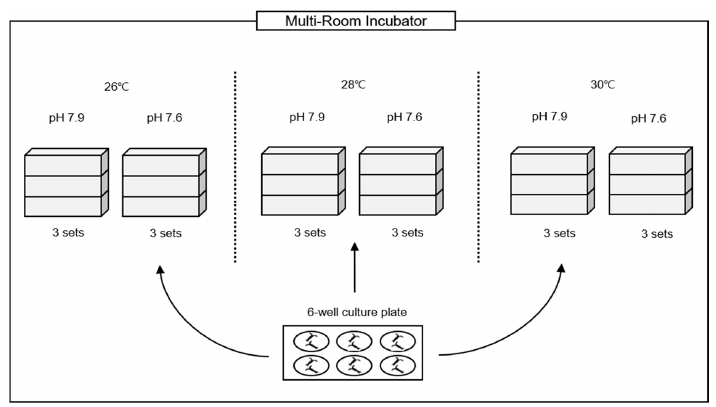
Figure 2. Illustration of the egg production rate and hatching success experiment.